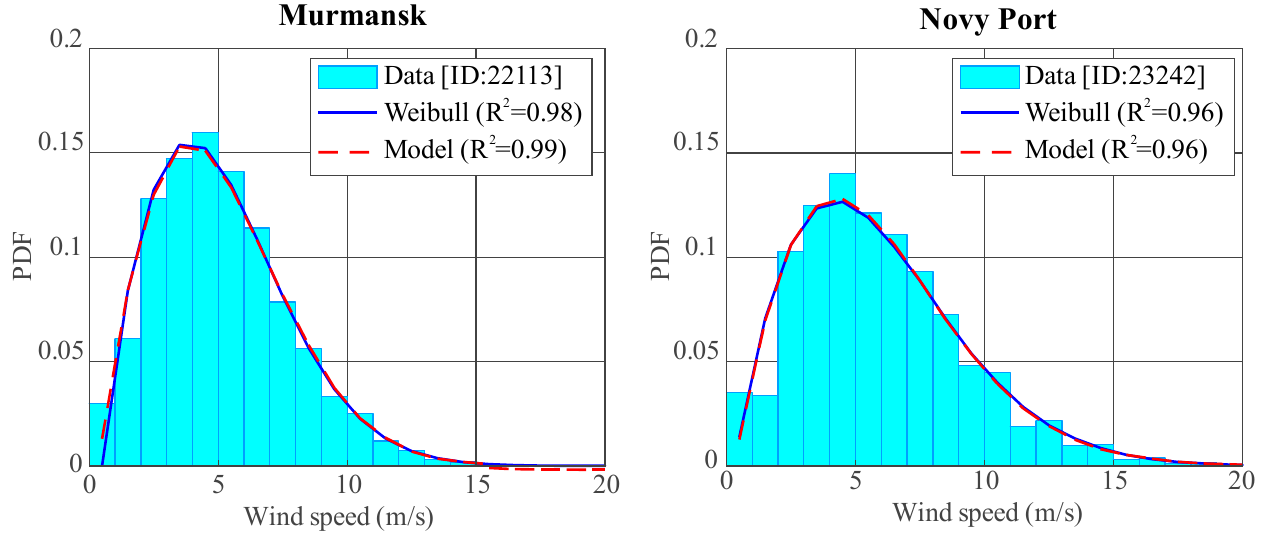
Figure 10. Probability distribution of real and simulated wind speed. A comparison of statistical point estimates of a real data sample and synthesized time series of wind speed using the standard and fractional models are shown in Table 2. Table 2. Descriptive statistics of real and simulated wind speed data.